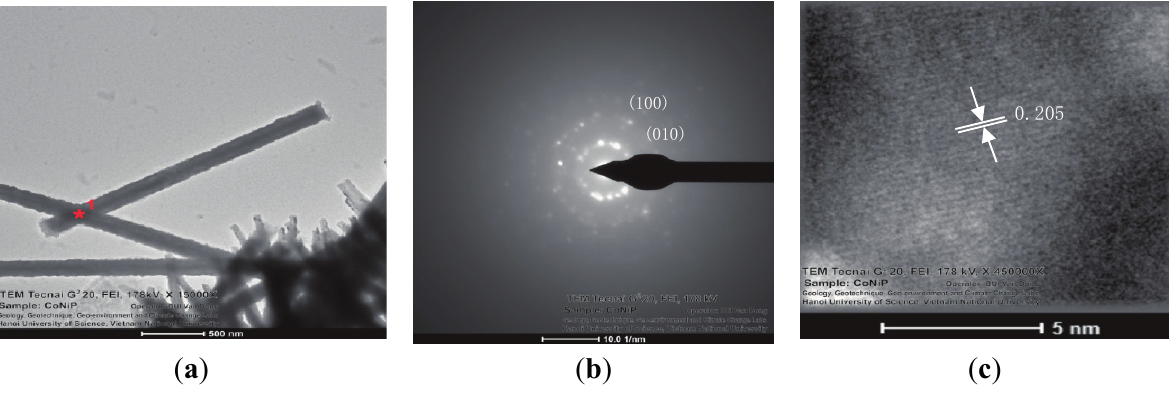
Figure 3. ( a ) A typical TEM image and ( b ) a SAED image of the 200 nm CoNiP nanowires; ( c ) an HRTEM micrograph of a single CoNiP nanowire.